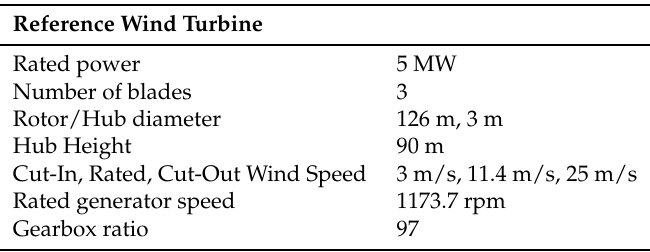
Table 1. Gross properties of the wind turbine [13].